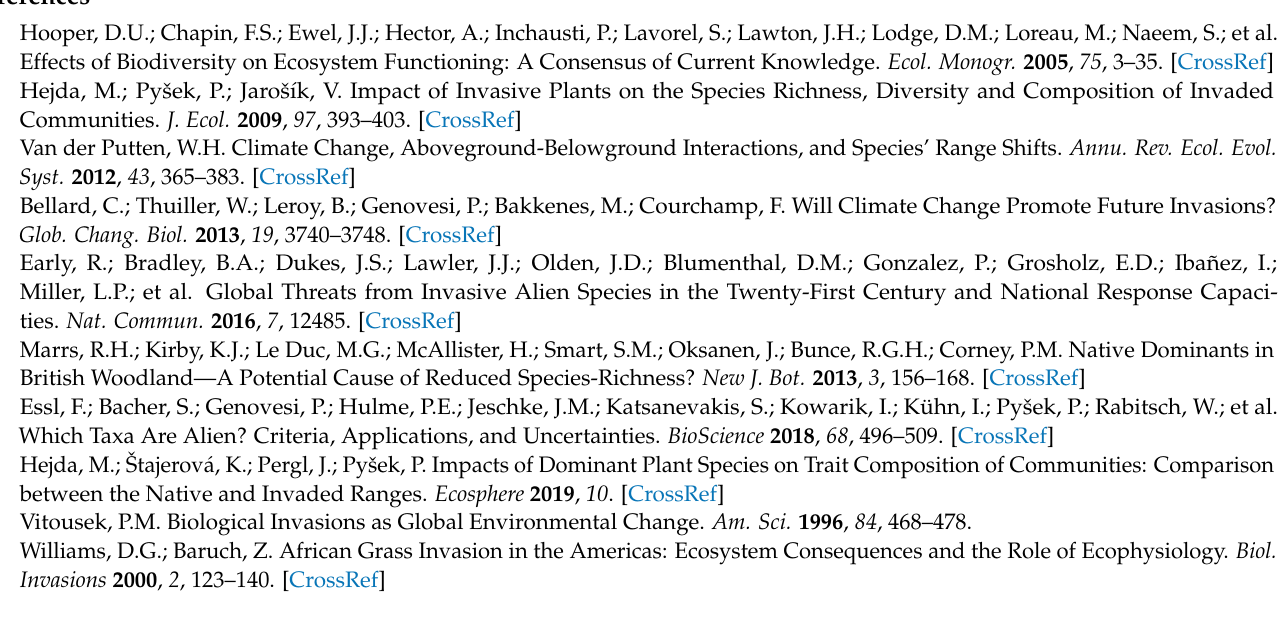
Figure S2: The spatial distribution of ARVI classes for three campaigns in the selected area; Figure S3: The spatial distribution of CAI classes for three campaigns in the selected area; Figure S4: The spatial distribution of CRI1 classes for three campaigns in the selected area; Figure S5: The spatial distribution of NDNI classes for three campaigns in the selected